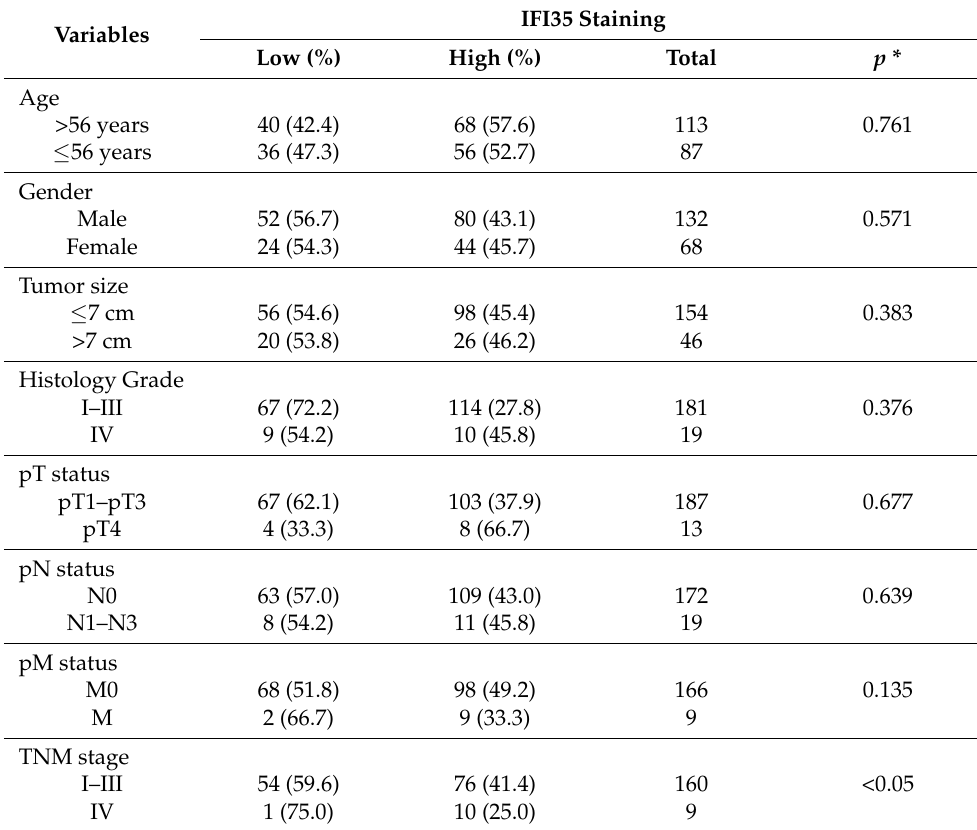
Table 1. IFI35 staining and clinicopathological characteristics of 200 RCC